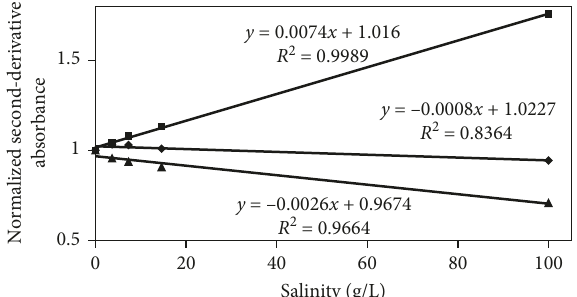
Figure 3: Normalized second-derivative absorbance as a function of salinity: values for N media ( N and AC , respectively)) are represented by diamonds and correspond to total sulfide (H 2 S/HS derivative values at 278nm for media H and representing total sulfite: SO 2 /HSO 3 media AC and representing total thiosulfate: H 2 S 2 O 3 /HS 2 O 3